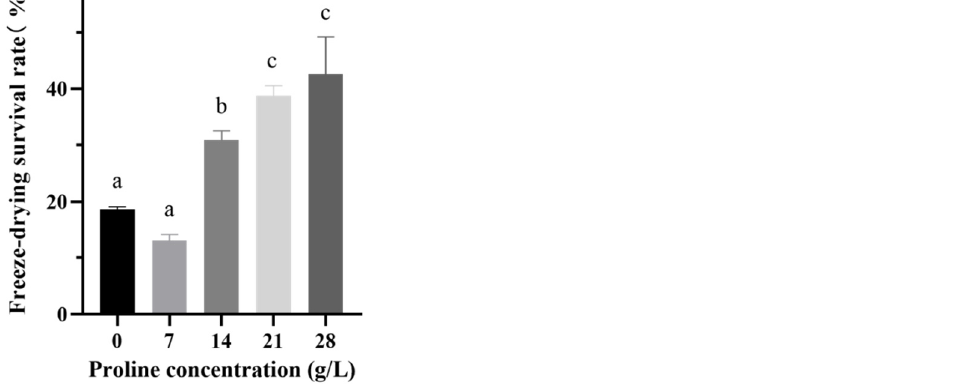
Figure 2. The freeze-drying survival rate of B. longum CCFM 1029 after adding different proline concentrations. Columns with different letters indicate significant differences ( p < 0.05).